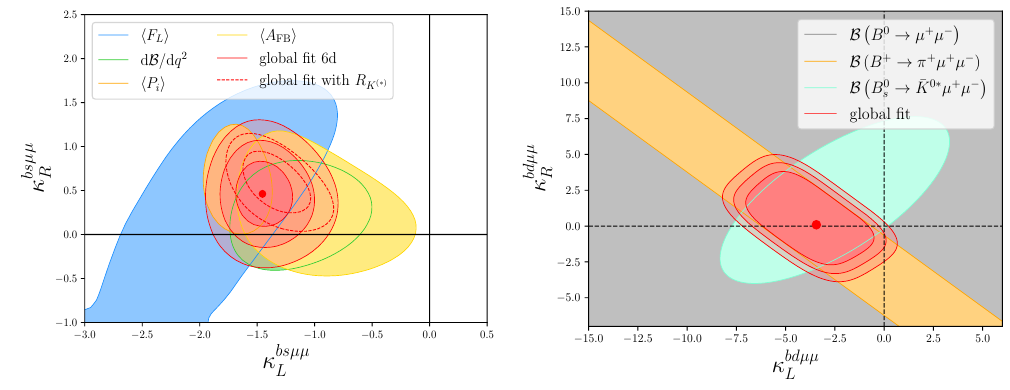
Figure 1 . Global fits to rare B -decay data on | ∆ b | = | ∆ s | = 1 (left panel) and on | ∆ b | = | ∆ d | = 1 transitions (right panel). Left plot: κ bsµµ – κ bsµµ plane with its best fit values (red point), and the L R 1 , 2 , and 3 σ contours (red shaded areas). 1 σ contours for different sets of observables are shown in blue for h F , green for h d B / d q 2 i , orange for h P , and yellow for h A . Red dashed contours L i i i FB i show the impact of R data, when included in the global fit. Right plot: 1 , 2 , and 3 σ fit contours K ( ∗ ) (red shaded areas) in the κ bdµµ – κ bdµµ plane and their best fit values (red point). The impact of L R ¯ B ( B + → π + µ + µ − ) and B ( B 0 → K ∗ 0 µ + µ − ) can be read off from their 1 σ contours, orange and s celeste, respectively. The B 0 → µ + µ − limit is included in the global fit, but of smaller impact (grey area, which fills the whole plot region). The | ∆ b | = | ∆ d | = 1 fit results are adapted from